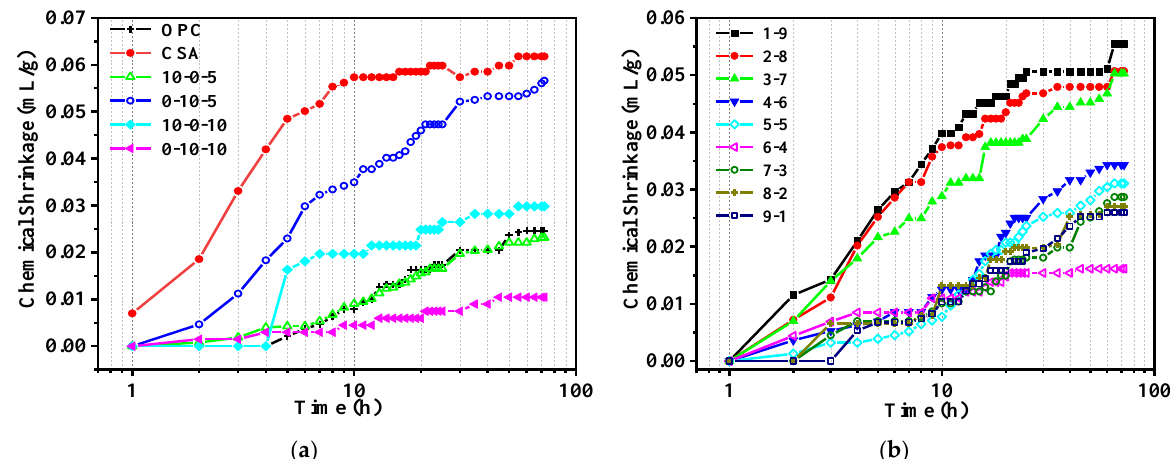
Figure 5. Chemical shrinkage of unitary systems and binary systems: ( a ) OPC or CSA or OPC-CS or CSA-CS blends; ( b ) OPC-CSA blends.